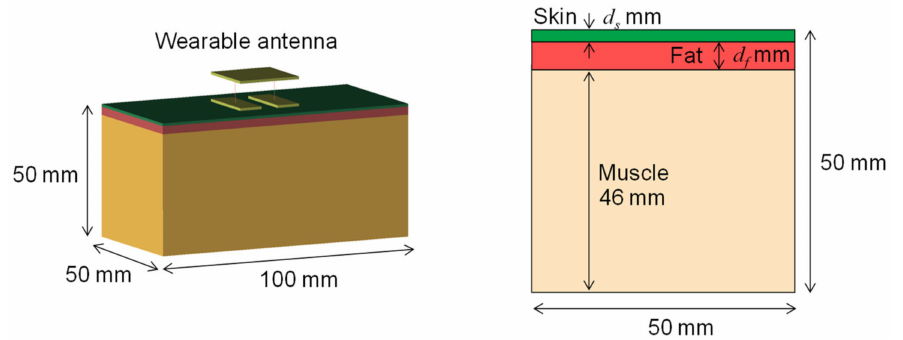
Figure 11. Simplified rectangular prism